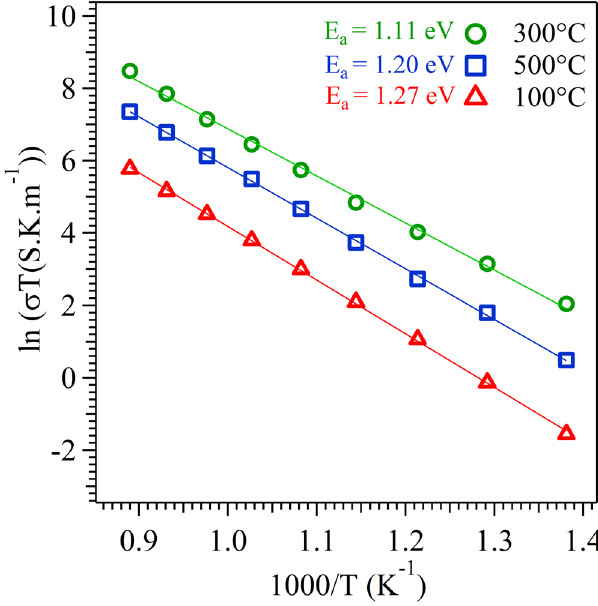
Figure 14. Arrhenius plot for a thin film with respect to the substrate